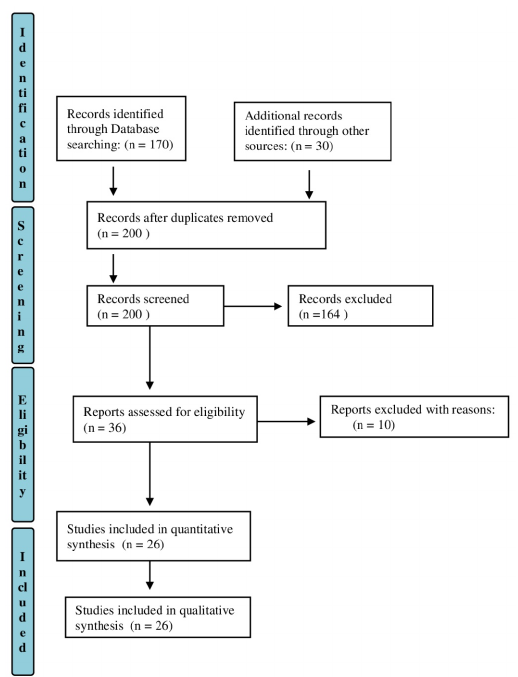
Figure 1. PRISMA flow diagram for study selection. Inclusion criteria were: (i) adult patients (age>/= 18), (ii) patients with severe stroke and severe TBI, (iii) other severe brain lesions that may cause a state of coma for at least